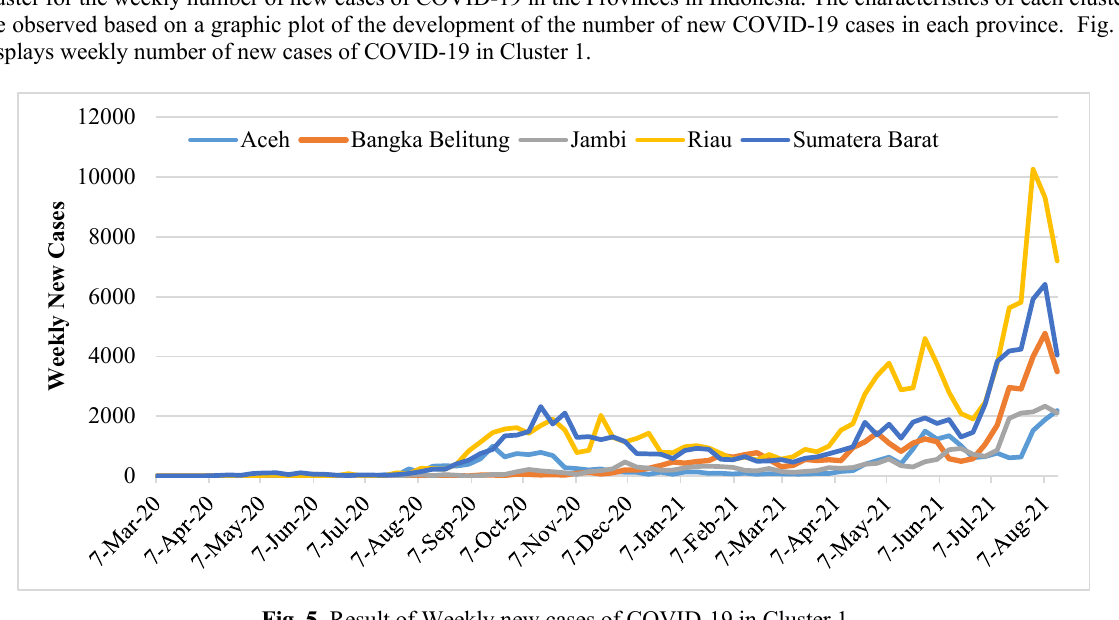
Fig. 5. Result of Weekly new cases of COVID-19 in Cluster